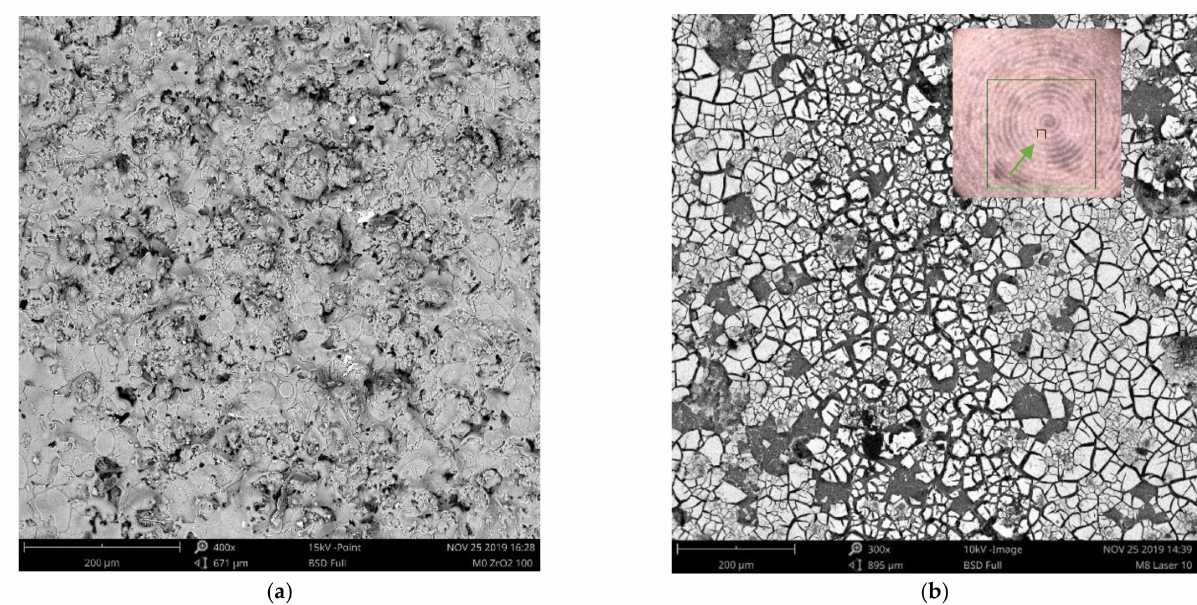
Figure 3. Scanning electron microscope (SEM) micrographs of the SSZ03 sample at different magnifications: ( a ) 480 × and ( b ) 1620 × .